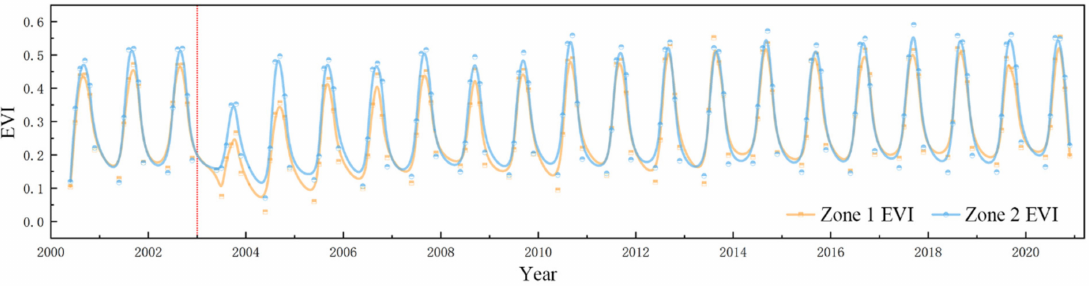
Figure 8. Monthly (April to September) B-spline change curve of EVI in which the red dotted line is the year of fire